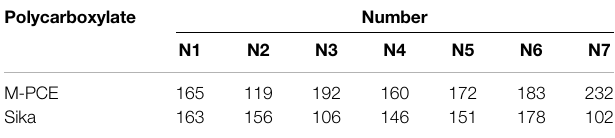
TABLE 4 | Initial fl owability of UHPC (mm).